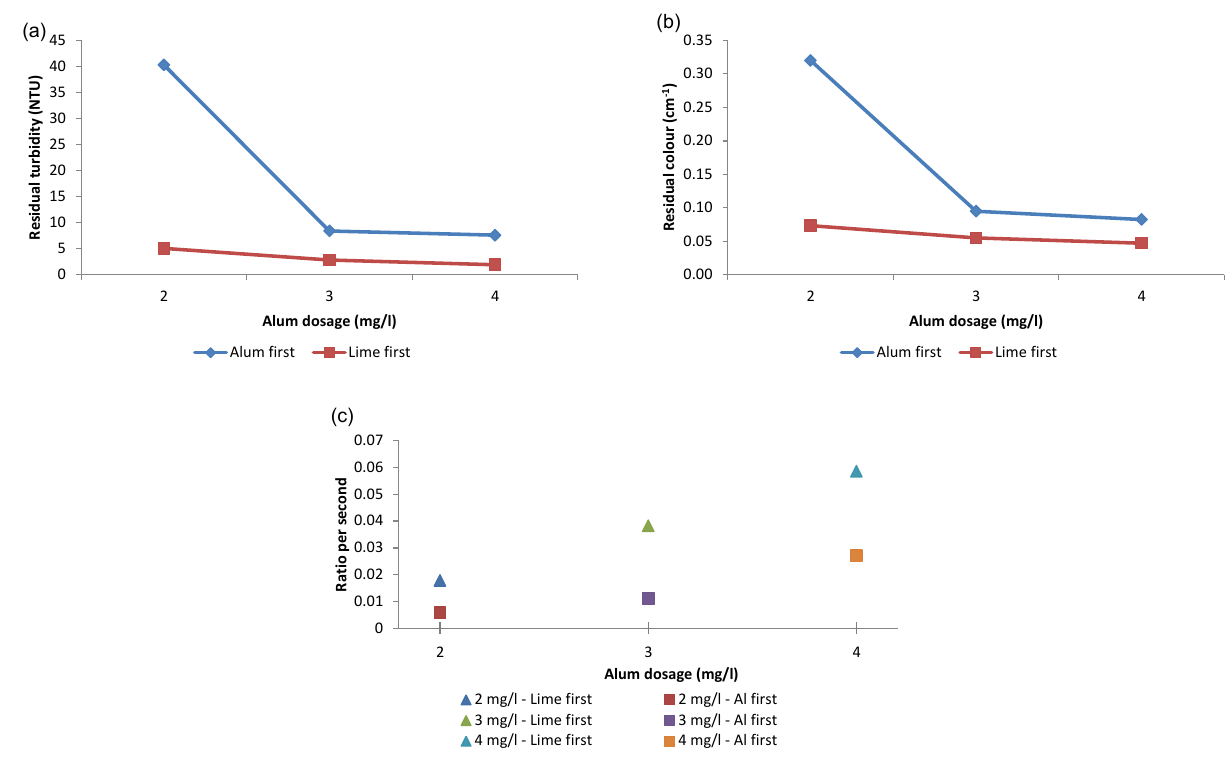
Figure 10. Impact of dosage sequence; (a) residual turbidity; (b) residual colour; (c) aggregation